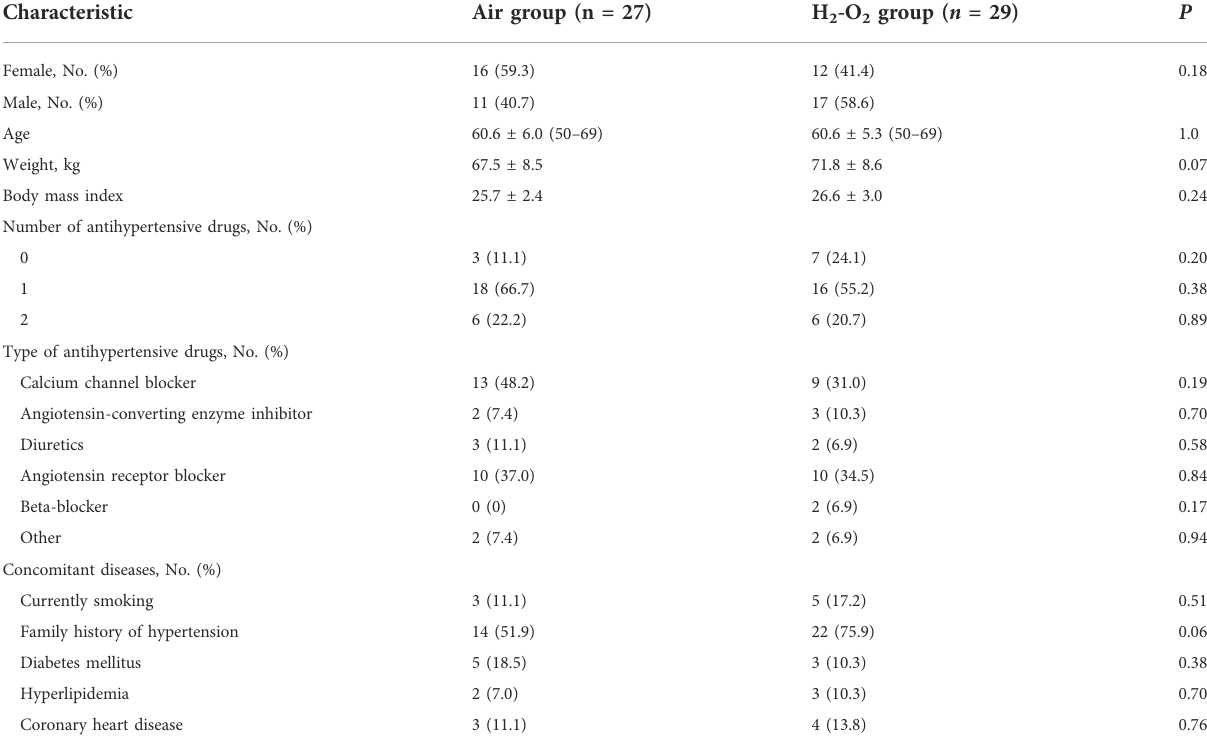
TABLE 1 Baseline characteristics of study subjects.